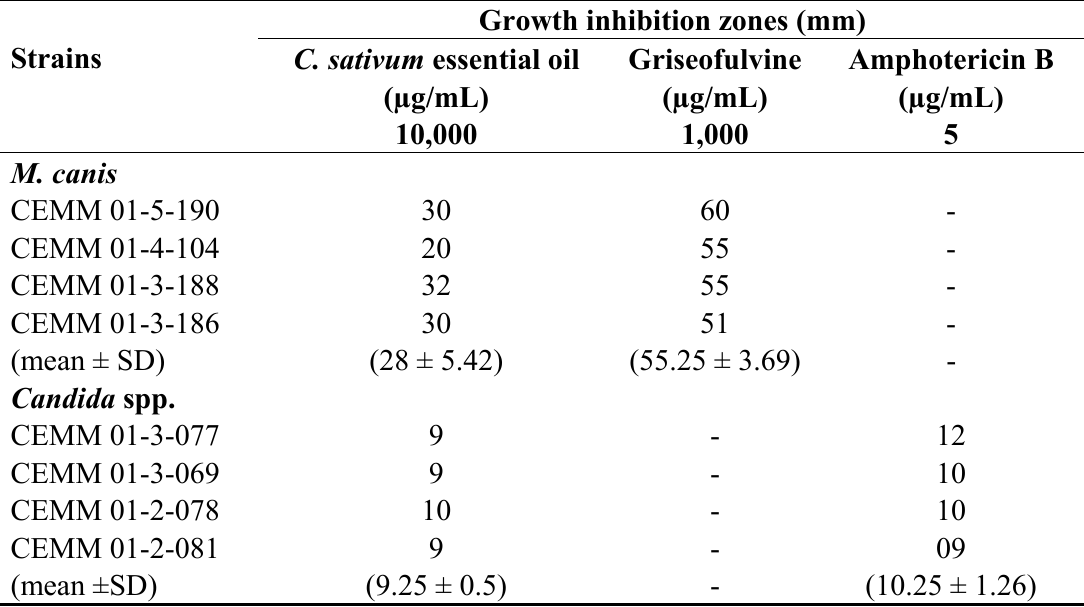
Table 2. Antifungal activity of the essential oil from C. sativum against Microsporum canis and Candida spp. in the agar-well diffusion assay.